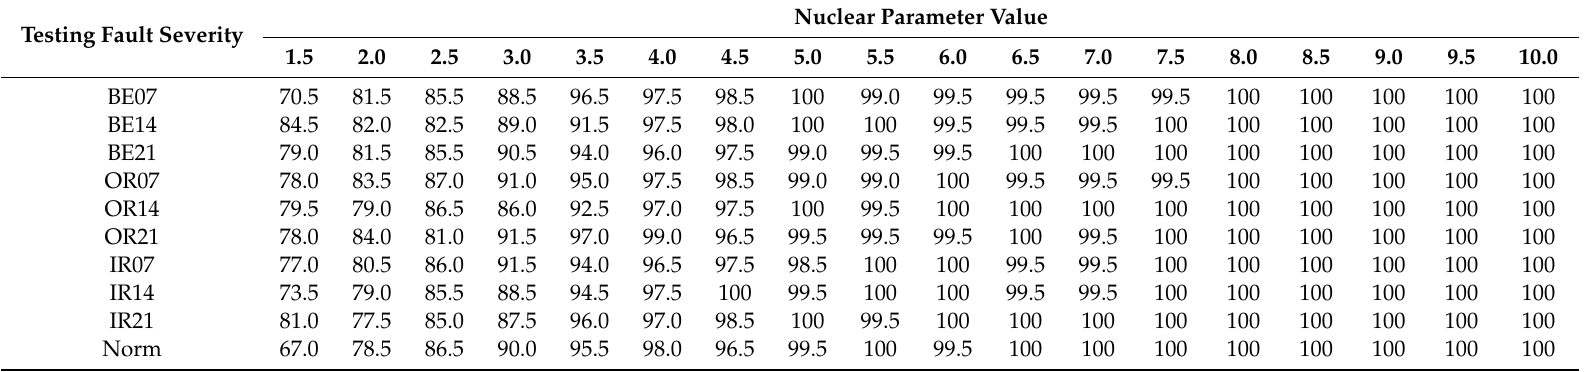
Table 18. The influence of nuclear parameter selection of the mRVM 2 _conv N on fault identification accuracy of the rolling bearing (%). Testing Fault Severity